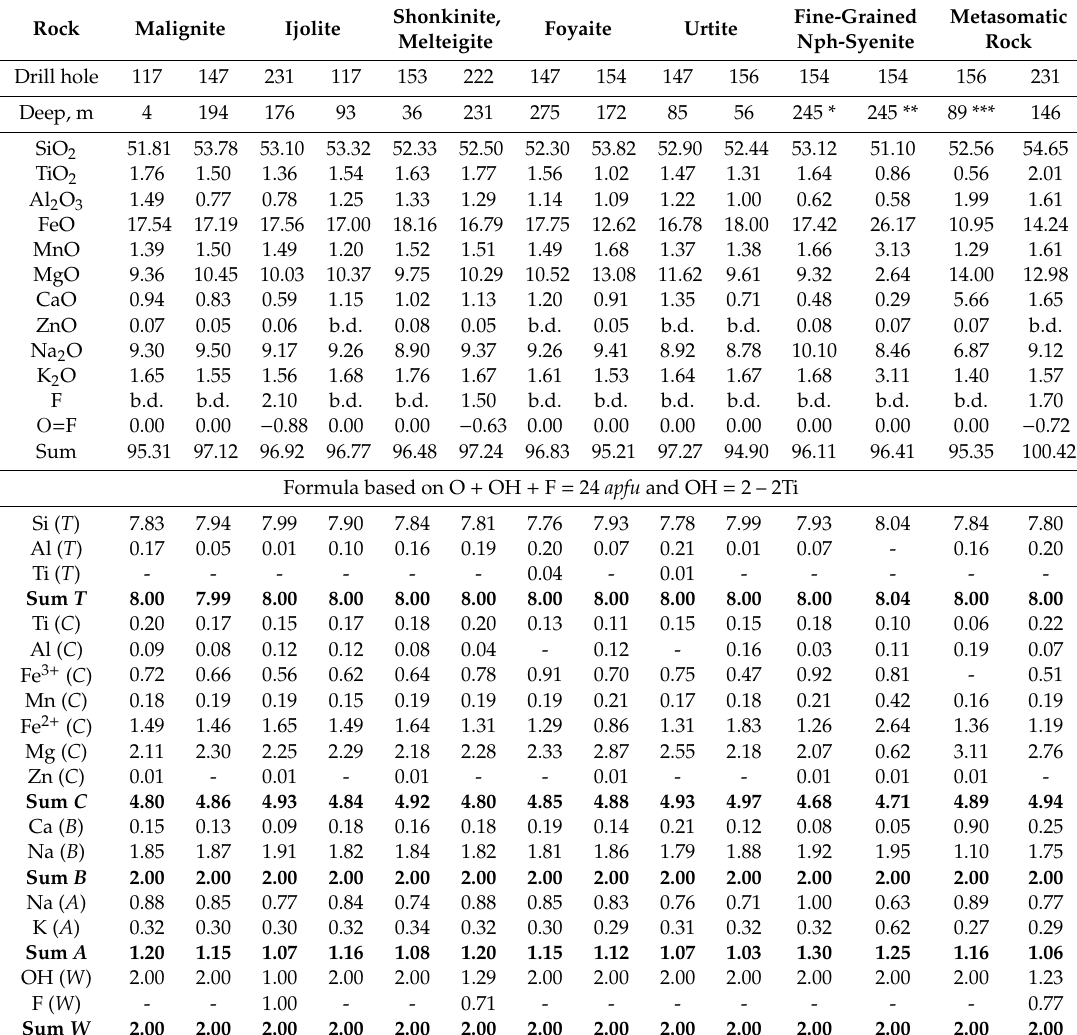
Table 4. Representative microprobe analyses of amphiboles, wt.